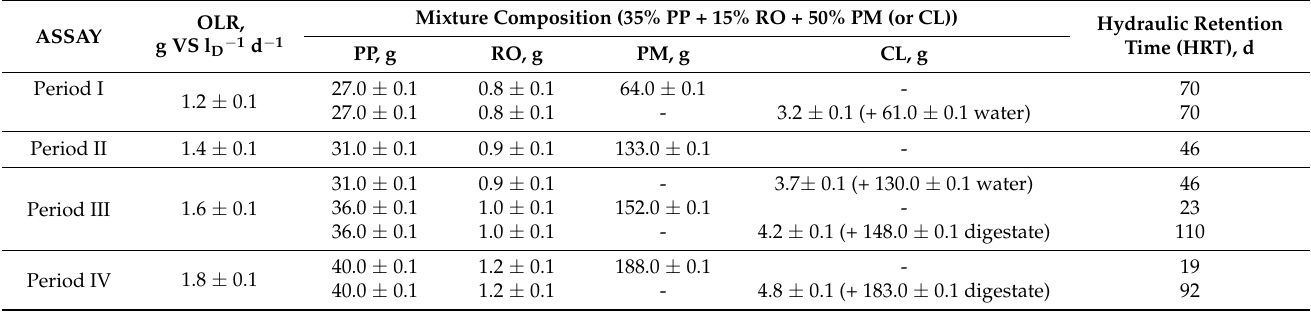
Table 1. Experimental design in evaluated assays